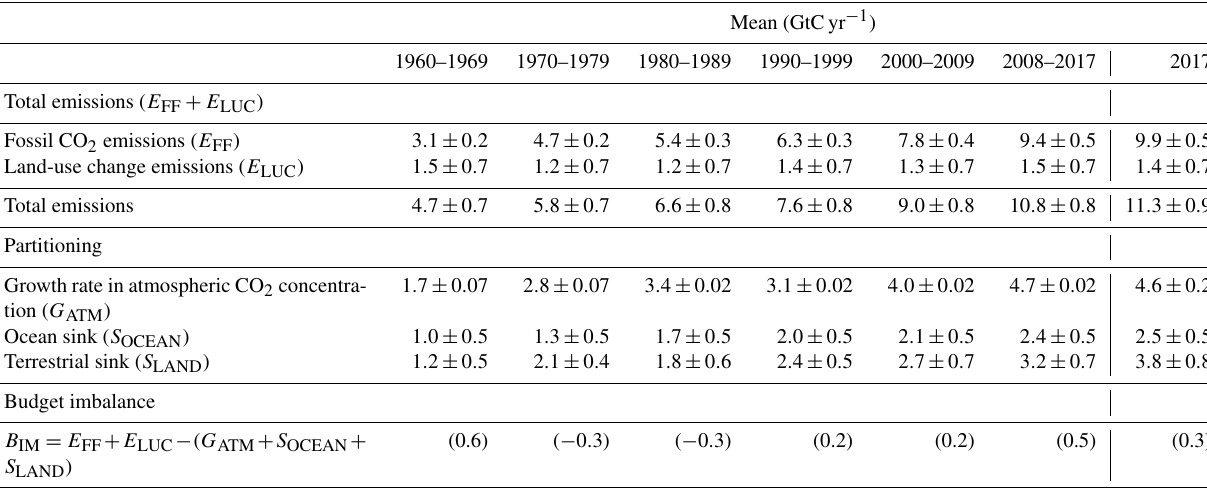
Table 6. Decadal mean in the five components of the anthropogenic CO 2 budget for different periods and the last year available. All values are in GtCyr − 1 , and uncertainties are reported as ± 1 σ . The table also shows the budget imbalance ( B IM ), which provides a measure of the discrepancies among the nearly independent estimates and has an uncertainty exceeding ± 1GtCyr − 1 . A positive imbalance means the emissions are overestimated and/or the sinks are too